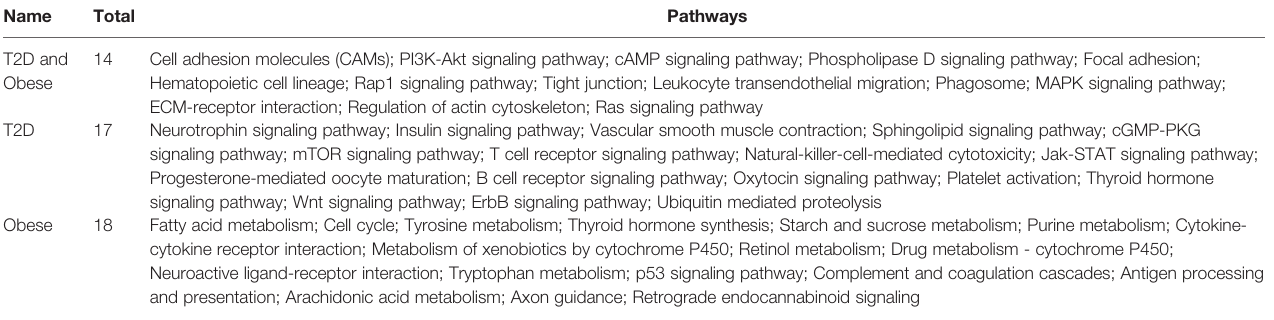
TABLE 1 | Pathways common between T2D and obesity and speci fi c to T2D and obesity (Venn diagram outcome).